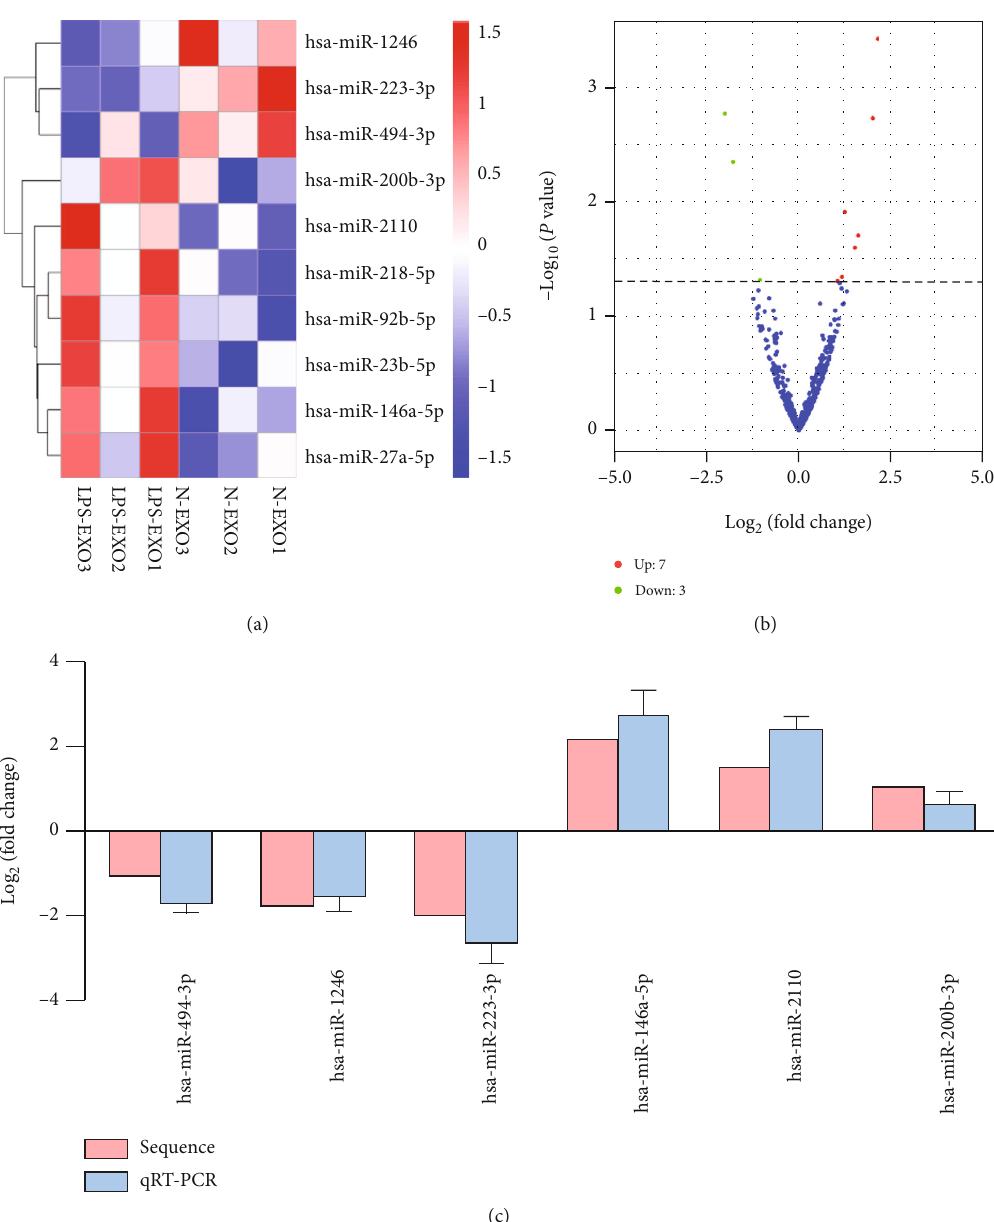
Figure 6: MicroRNA sequencing of N-EXO and LPS-EXO from hDPSCs. (a) Heat map and cluster analysis show that the expression of 10 microRNAs was signi fi cantly changed in LPS-EXO, and of these microRNAs, 7 were increased and 3 were decreased. (b) MicroRNA volcano plot. (c) Comparison of microRNA sequencing and qRT-PCR data ( n = 3 ). Data represent means ± SD